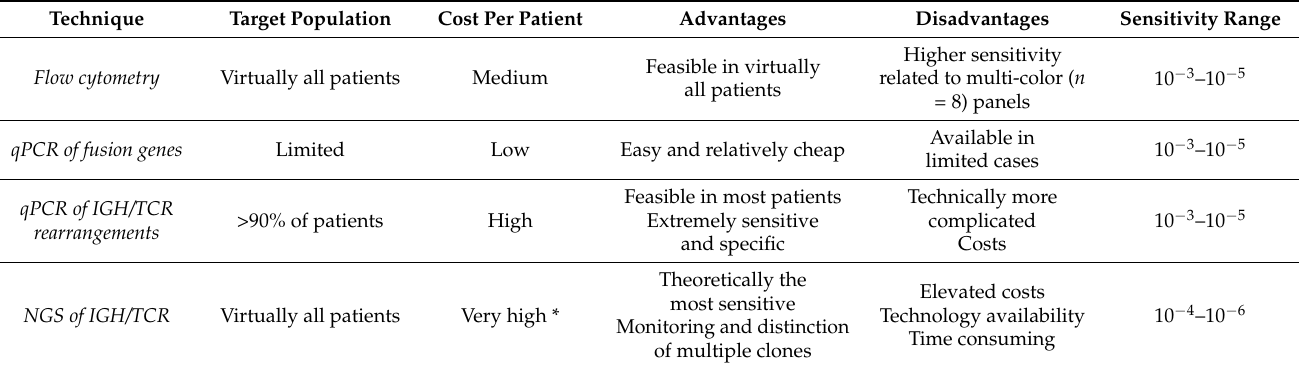
Table 3. Main features of different techniques for MRD monitoring in